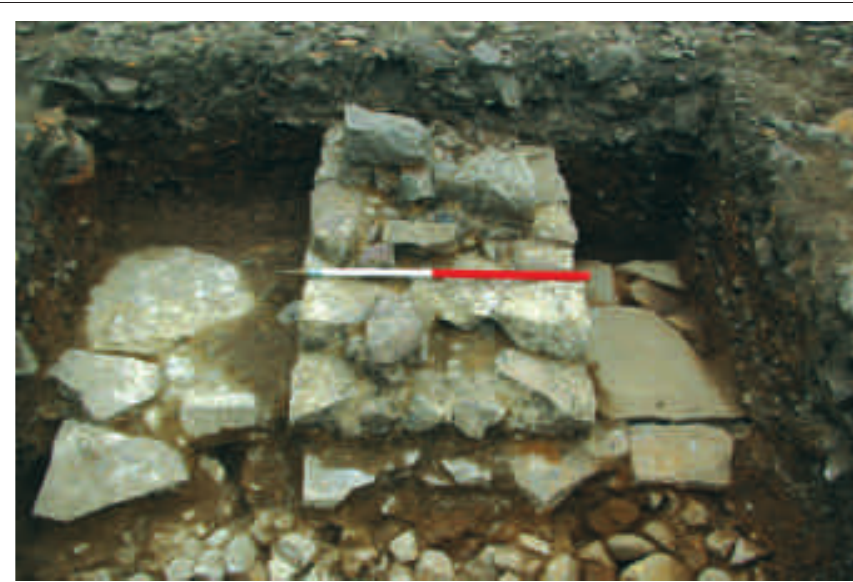
Figure 4 Internal partition wall of the store-building, with flagstone flooring levels on either side